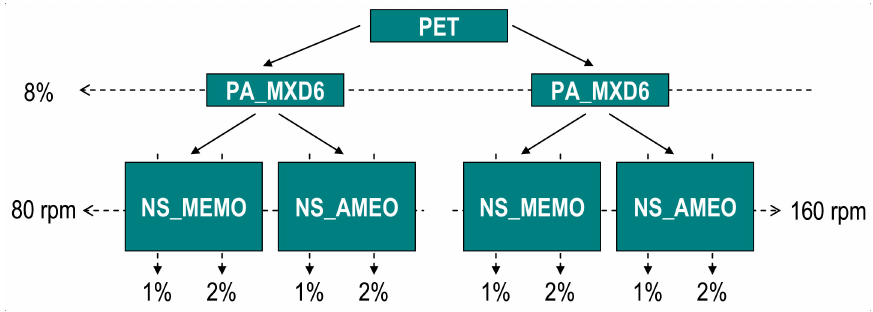
Figure 1. Samples